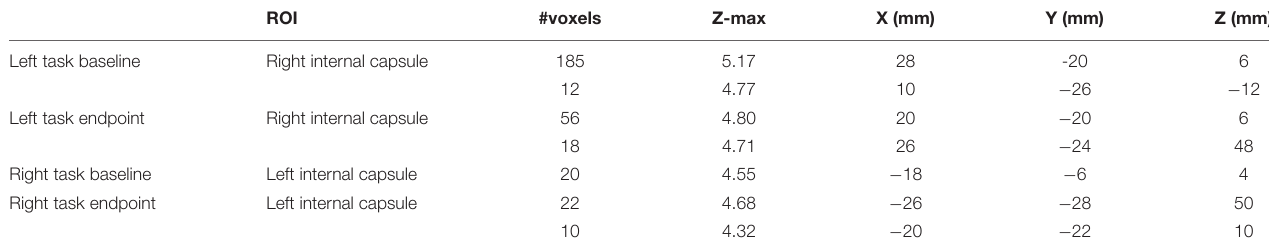
FIGURE 1 | WM activation revealed in the internal capsule. Activation is lateralized as expected, and still present when conservatively thresholded masks are applied. Images displayed in radiological convention, right side of brain on left side of image. ( z > 4, P < 0.05, FWE corrected). TABLE 1 | Voxels showing activation within the internal capsule at each timepoint ( z > 4, P < 0.05, FWE corrected, clusters of 10 or more voxels reported).